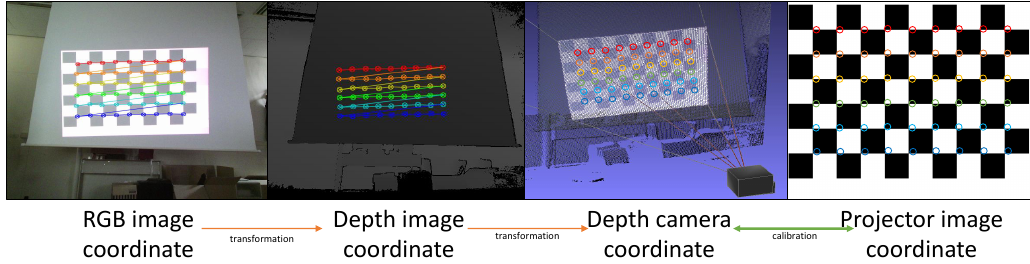
Figure 3. An example of the sampling procedure for calibration between the projector image coordinates and the depth camera